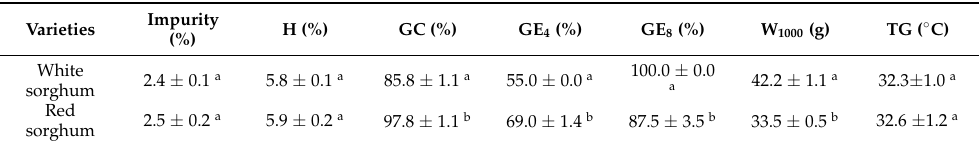
Table 1. Physicochemical characteristics of some grains of sorghum sampled in the main markets of Maroua town and used for the production of the indigenous beers.